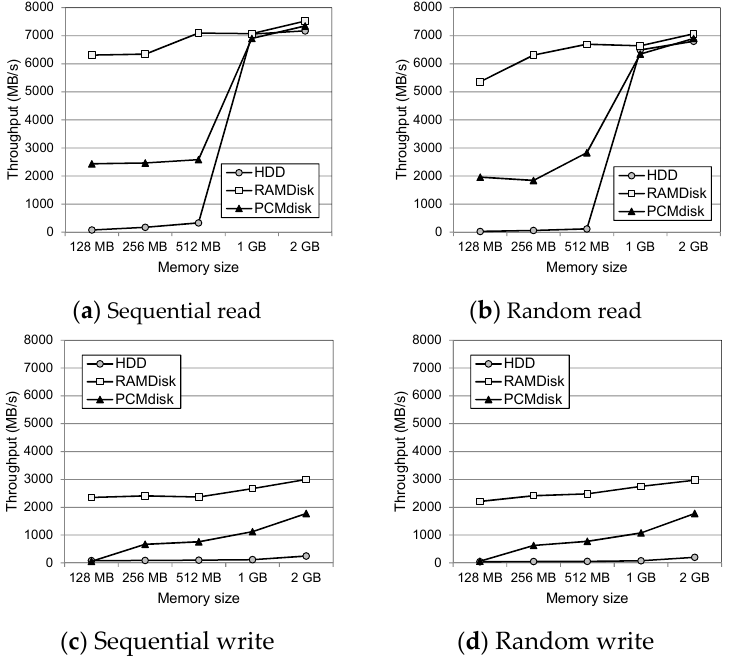
Figure 1. Performance comparison of a hard disk drive (HDD), RAMDisk, and phase-change memory (PCM) disk varying the main memory size.